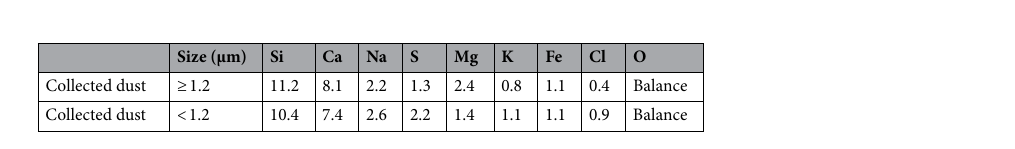
Table 1. Elemental composition of dust particles